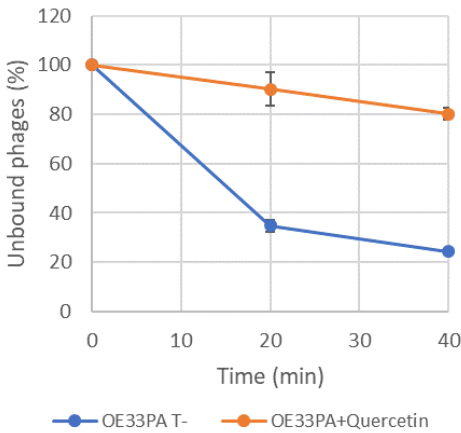
Figure 3. Adsorption assay of phage OE33PA on O. oeni IOEBS277. Cells were grown in MRS in the absence (blue) or presence of quercetin (50 µ g mL − 1 ) (orange). The test was done in the same media and infection was carried out at an MOI of 0.003.